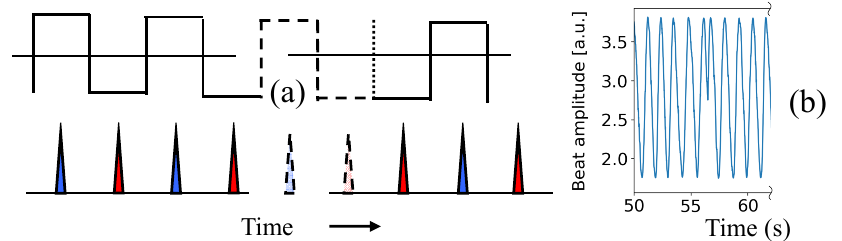
Figure 8. ( a ) Top: square wave applied to the phase modulator. Bottom: pulse sequence in the OPO, with the blue pulses experiencing a positive phase shift, the red ones a negative one. Dashed lines indicate a break in the triggering of the square wave. If the trigger of the square wave is interrupted for an odd number of pulses (dashed lines), the phase of the square will experience a shift of π ; ( b ) a Bottom: pulses in the OPO, labeled blue for having the phase shift  red for the phase shift   random occurrence of phase flip is The pulses trigger the square wave driving the phase modulator. If there is a break in the triggering pulse sequence, there is a 50% probability that the phase of the square wave will be flipped when the pulse sequence resumes, as indicated in the figure.